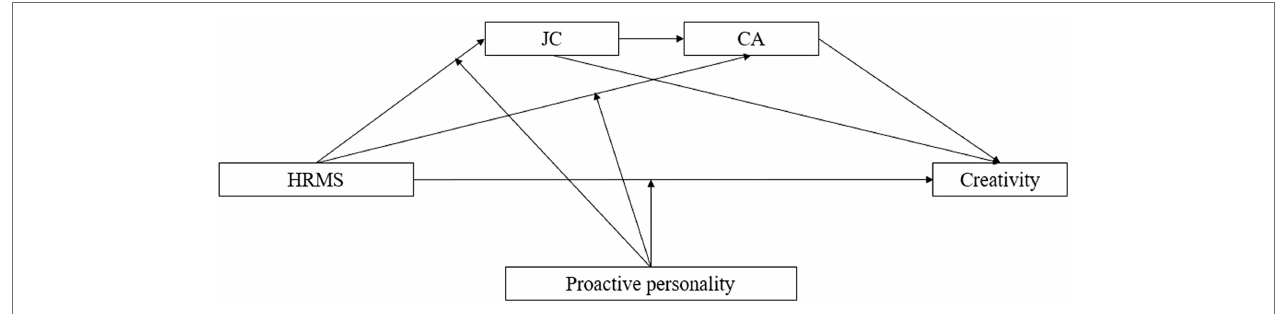
FIGURE 1 | Theoretical model. HRMS, human resource management; JC, job crafting; and CA, career